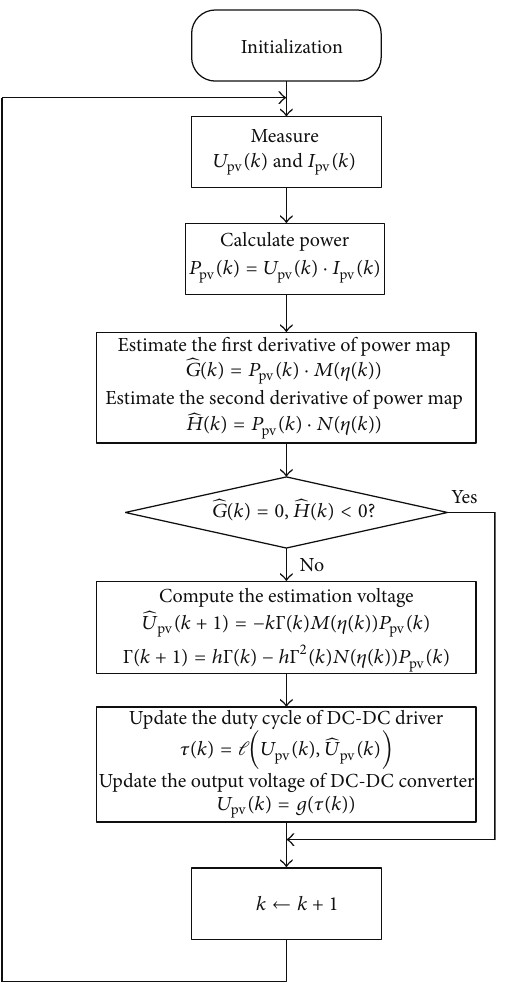
Figure6:FlowchartoftheNewton-basedextremumseekingMPPT method.